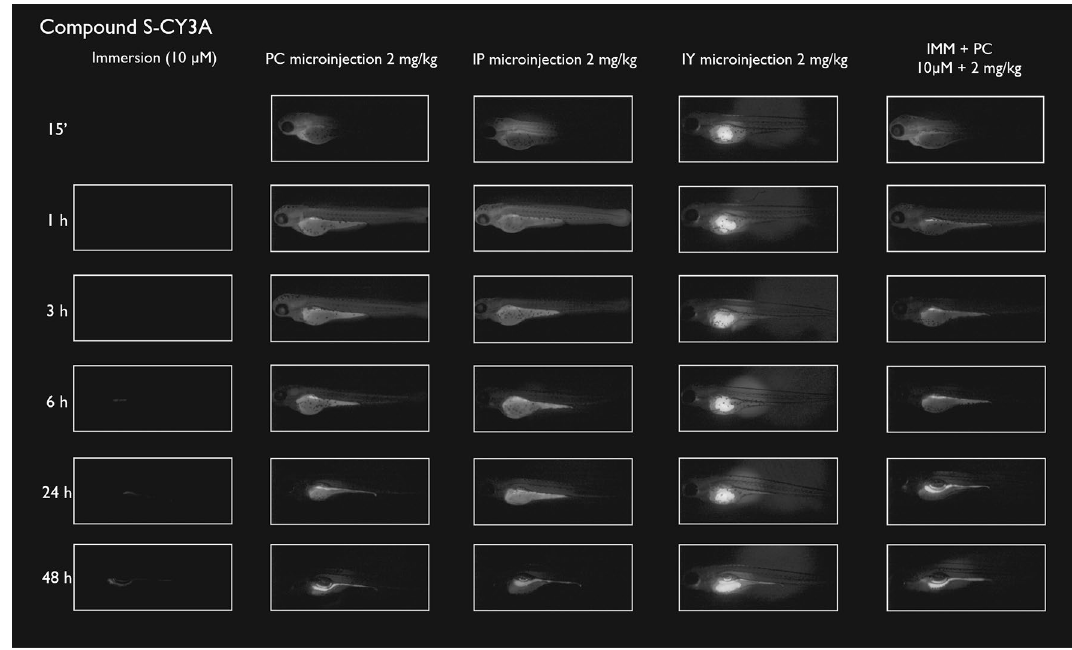
Figure 1. Representative pictures of the spatiotemporal distribution of the fluorescent compound S-CY3A. The eleuthero-embryos were exposed to the dye by immersion (10 µM) or microinjection (2 mg/kg) in the pericardial cavity (PC), intraperitoneally (IP) and in the yolk sac (IY), or by a combination of immersion and PC microinjection, for 48 h starting from 3 dpf. Selected images arranged in MS PowerPoint and GIMP (version 2.10.24 https:// www. gimp. org/ 2021)